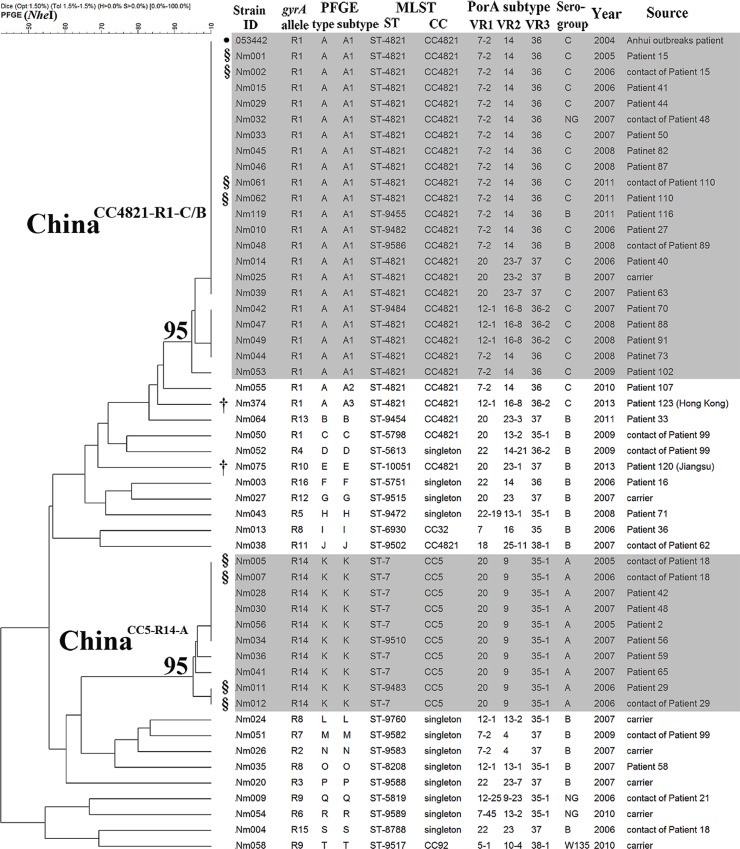
Dendrogram of 51 ciprofloxacin-nonsusceptible N. meningitidis strains from patients and carriers in Shanghai, China, 2005–2013, constructed using pulsed-field gel electrophoresis—NheI.The clones ChinaCC4821-R1-C/B and ChinaCC5-R14-A are indicated in grey shading, with the relatedness values marked on the roots. ●The PFGE data for the Anhui outbreak strain 053442 were obtained from PulseNet China. §Clonal dissemination between patients and their close contacts was observed. †Imported cases. NG, non-groupable.